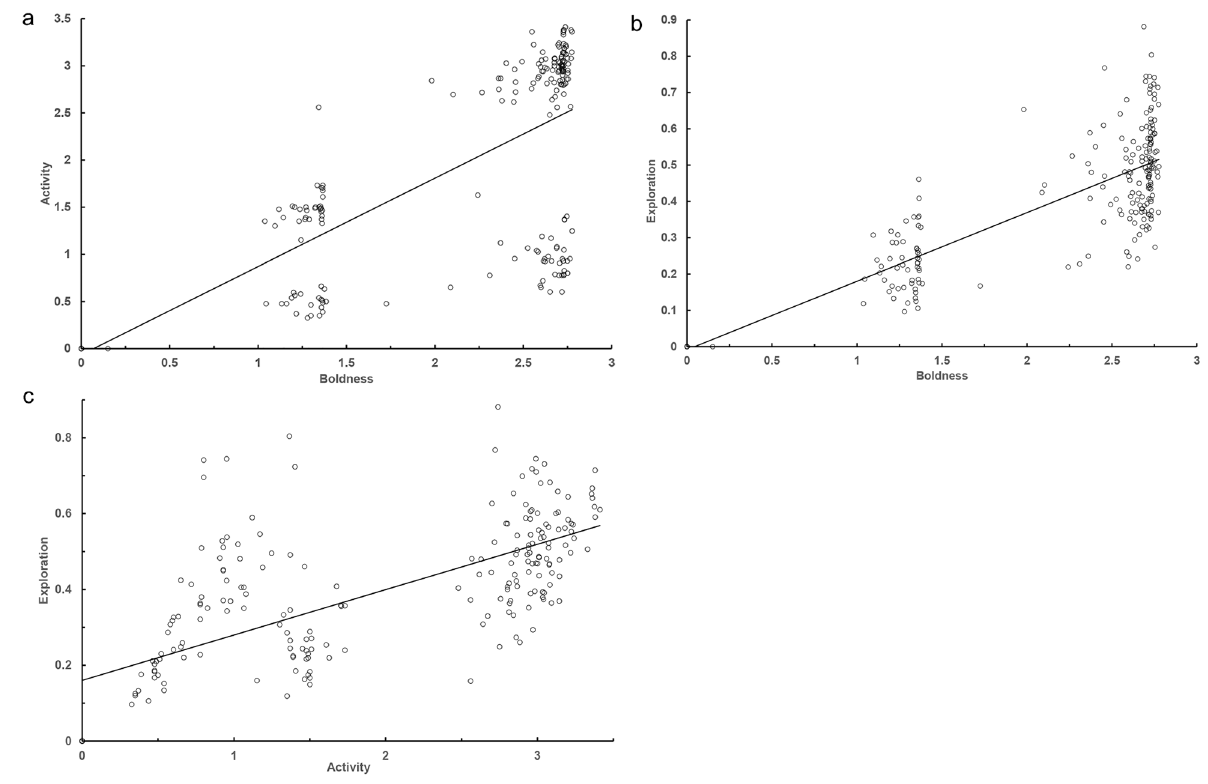
Fig. 2 Correlation of normalized values of repeatable behaviors between paired behavioral categories (a) boldness-activity, (b) boldness-exploration, and (c) activity-exploration assessed for eastern bent-wing bats in hole-board box